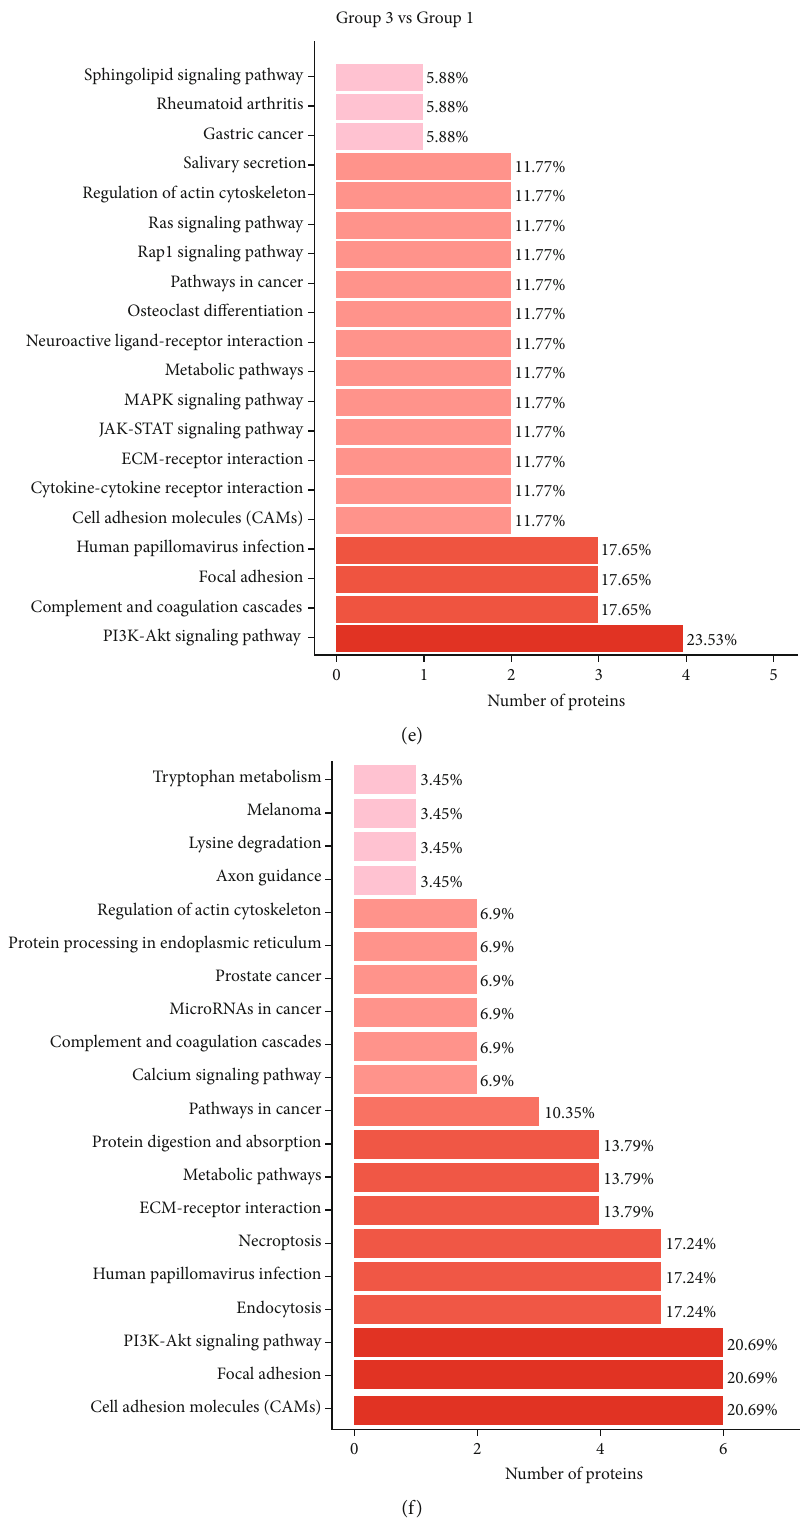
Figure 4: The protein-protein interaction (PPI) networks of common DEGs. (a – c) The comparisons of PPI networks of DEGs are shown among the indicated groups (group 1: healthy controls, group 2: inactive JSLE patients, and group 3: active JSLE patients) by using the STRING online database. The top 20 enrich KEGG pathways are selected and classi fi ed into hierarchical categories according to the comparison between